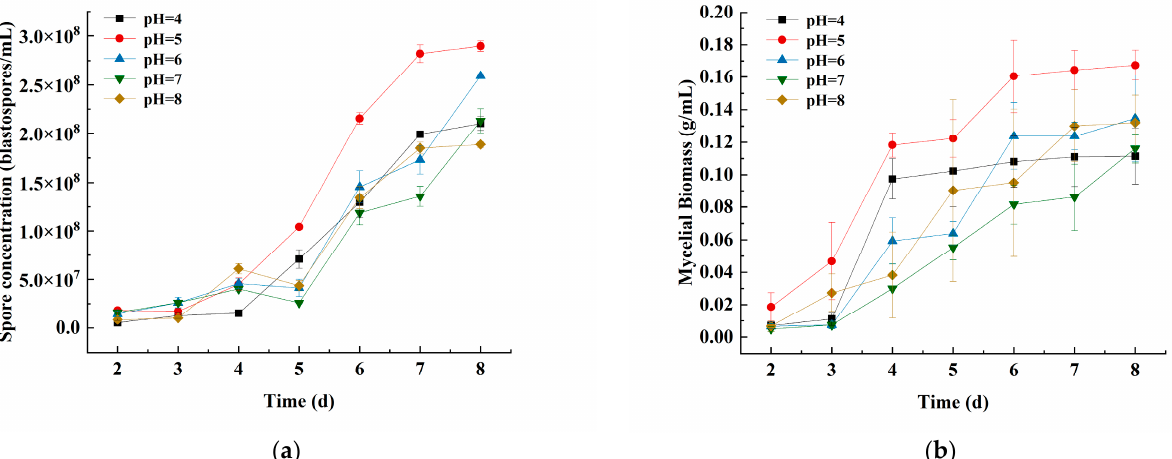
Figure 2. Effects of different initial pH on the ( a ) spore concentration and ( b ) mycelial biomass of strain JMF-01. The data in the figure are the mean ± SEM. The SEM of three repetitions is shown in